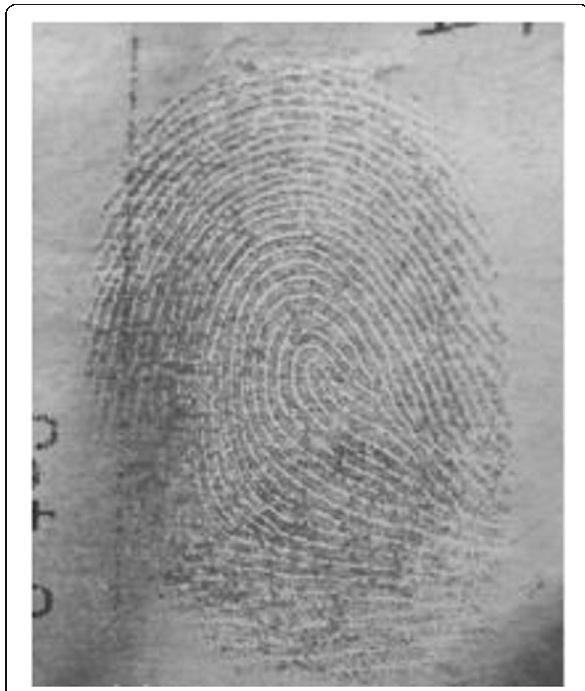
Fig. 4 Example of fingerprints on thermal paper developed using controlled heat (adapted from Bond